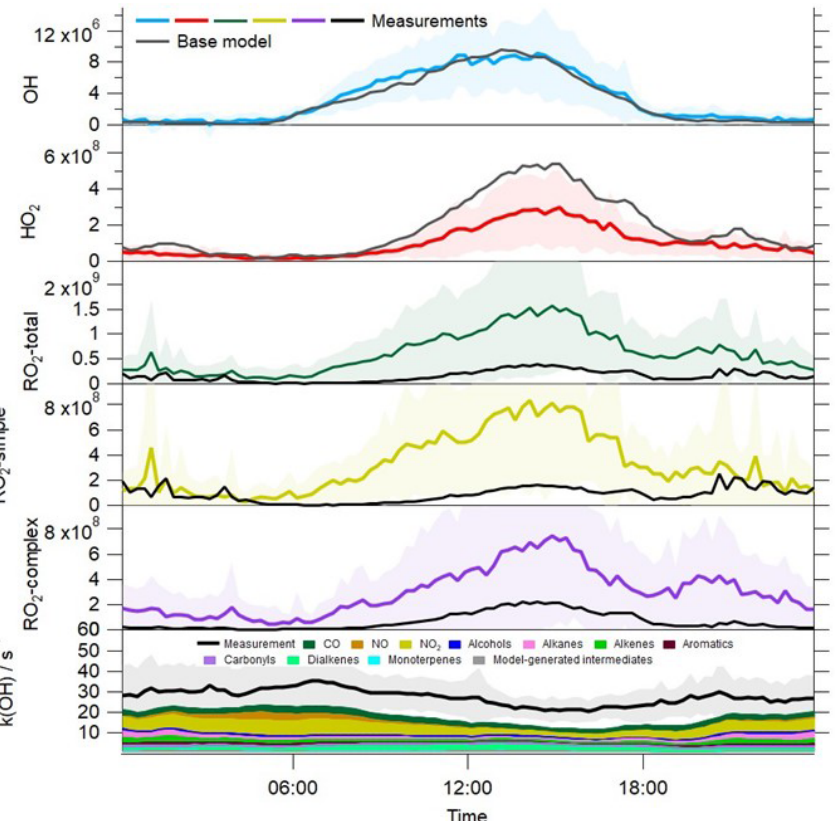
Figure 5. Average profiles for the observed OH, HO 2 , total RO 2 , partially speciated RO 2 (in moleculecm − 3 ) and OH reactivity at 15min intervals over 24h. The error bars represent the 1 σ standard deviation of the measurements, representing the variability in the measurements from day to day. The average diurnal profiles for OH, HO 2 , total RO 2 , partially speciated RO 2 and OH reactivity from the base model are